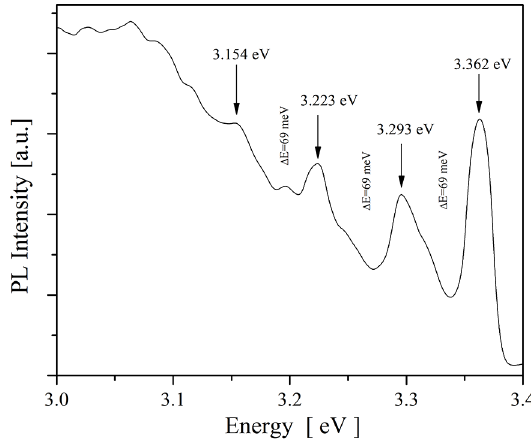
Figure 5. 10 K PL spectrum of a GaN film, showing the phonon replica.